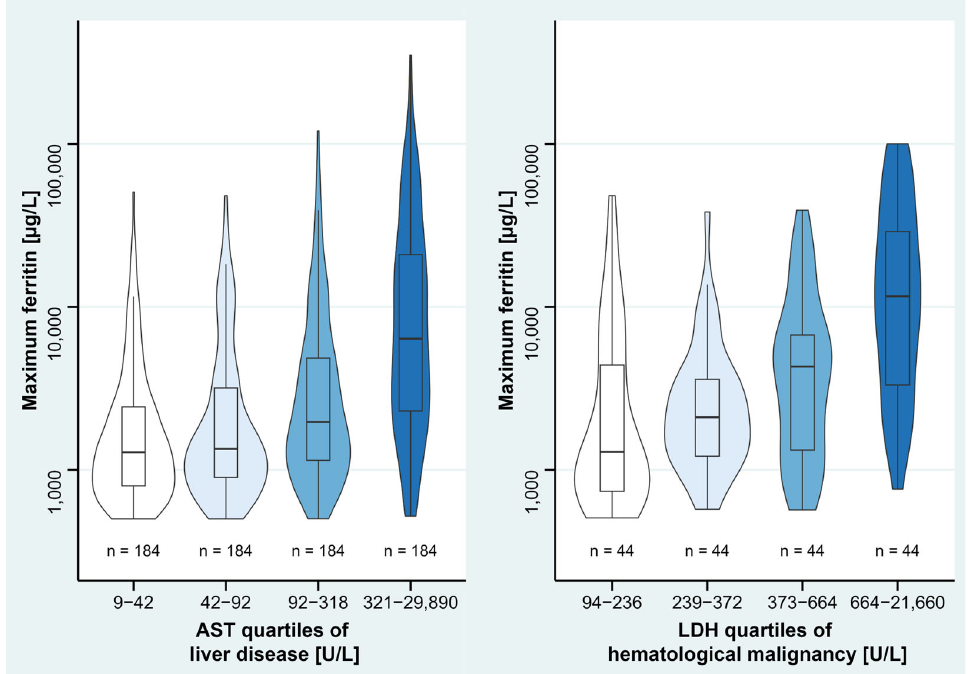
Figure 5. Ferritin levels of liver disease and hematological malignancy, divided into quartiles of their diagnostic markers. Violin plots show data distribution and enclosed boxplots show median with quartiles (25–75%). Whiskers below and above show minimum and maximum values, respectively. For improved visualization, y ‐ axis is plotted in logarithmic scale. Due to various numbers of ICD ‐ 10 codes in each single patient, patients partially overlap between the disease groups. AST, aspartate aminotransferase. LDH, lactate dehydrogenase.